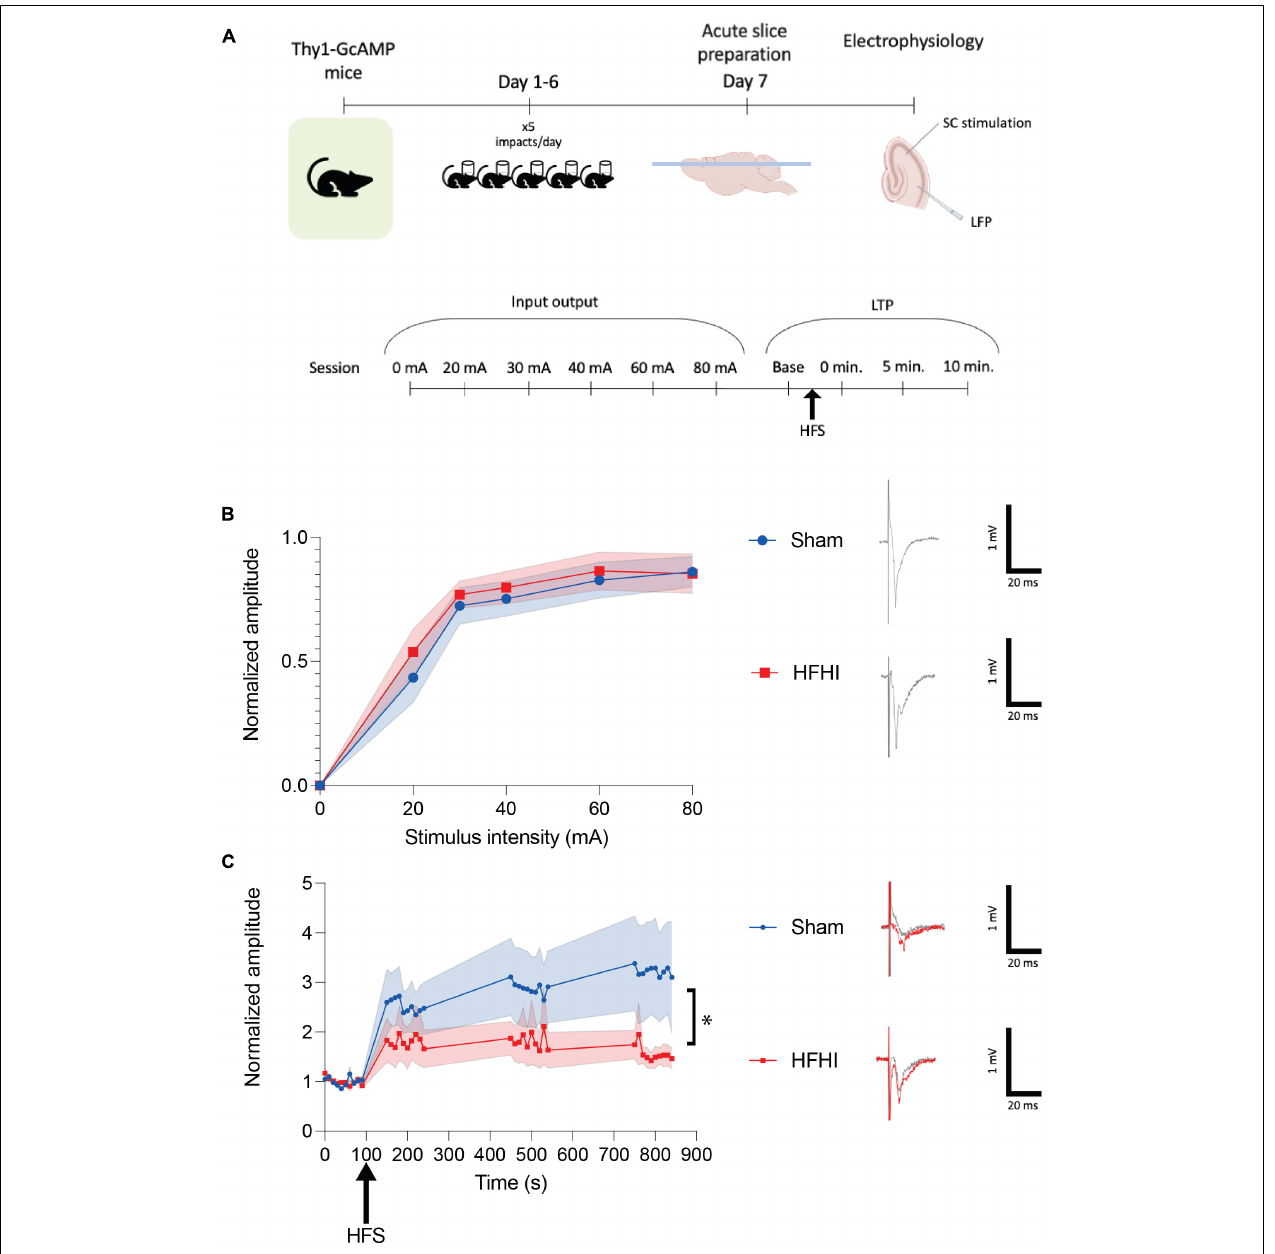
FIGURE 1 | High Frequency Head Impact (HFHI) decreases hippocampal early-LTP. (A) Acute slices from Thy1-GCaMP6f mice were prepared 24 h following the last day of HFHI and field recordings in the CA1 field were performed during an abbreviated LTP paradigm. (B) HFHI does not alter the input output response (quantified in left, example traces from 80 mA shown on right). (C) A significant interaction between time and group in early-LTP was seen following HFHI (quantified in left, example traces from immediately post-HFS shown on right). Shaded regions represent mean ± SEM. Mixed effects analysis, * p < 0.05, n Sham = 8, n HFHI = 9.